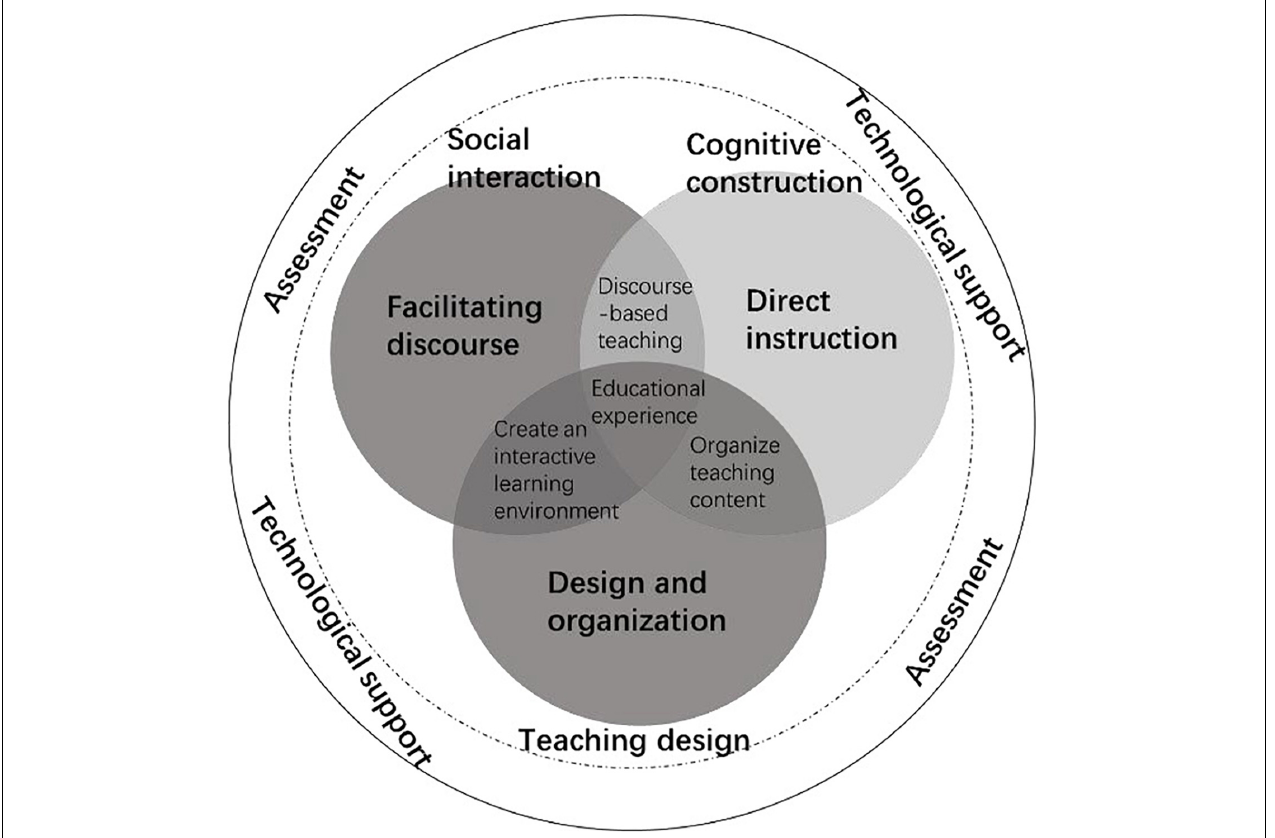
FIGURE 2 | Teaching presence measurement